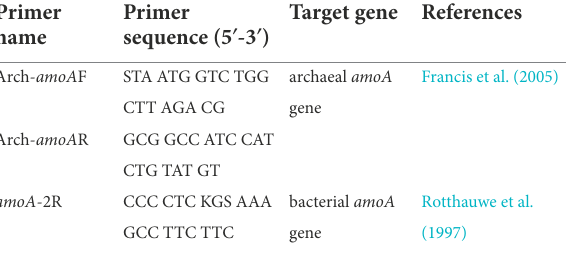
TABLE 2 Primers and conditions used in this